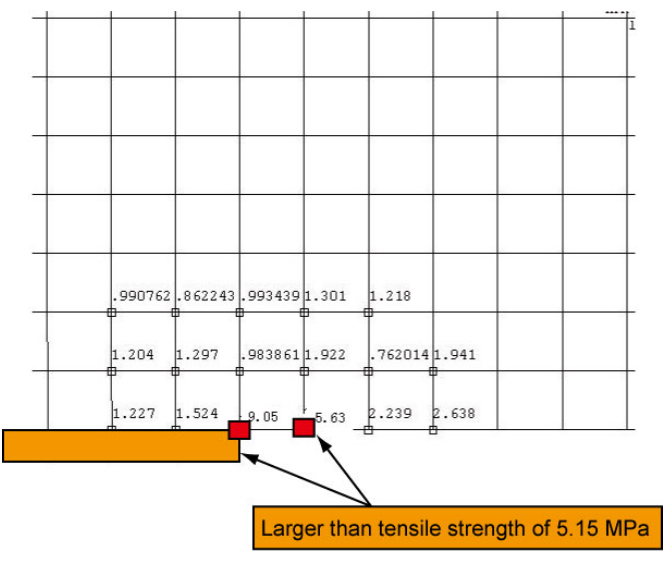
Figure 17. The specific value around the region at the end of the